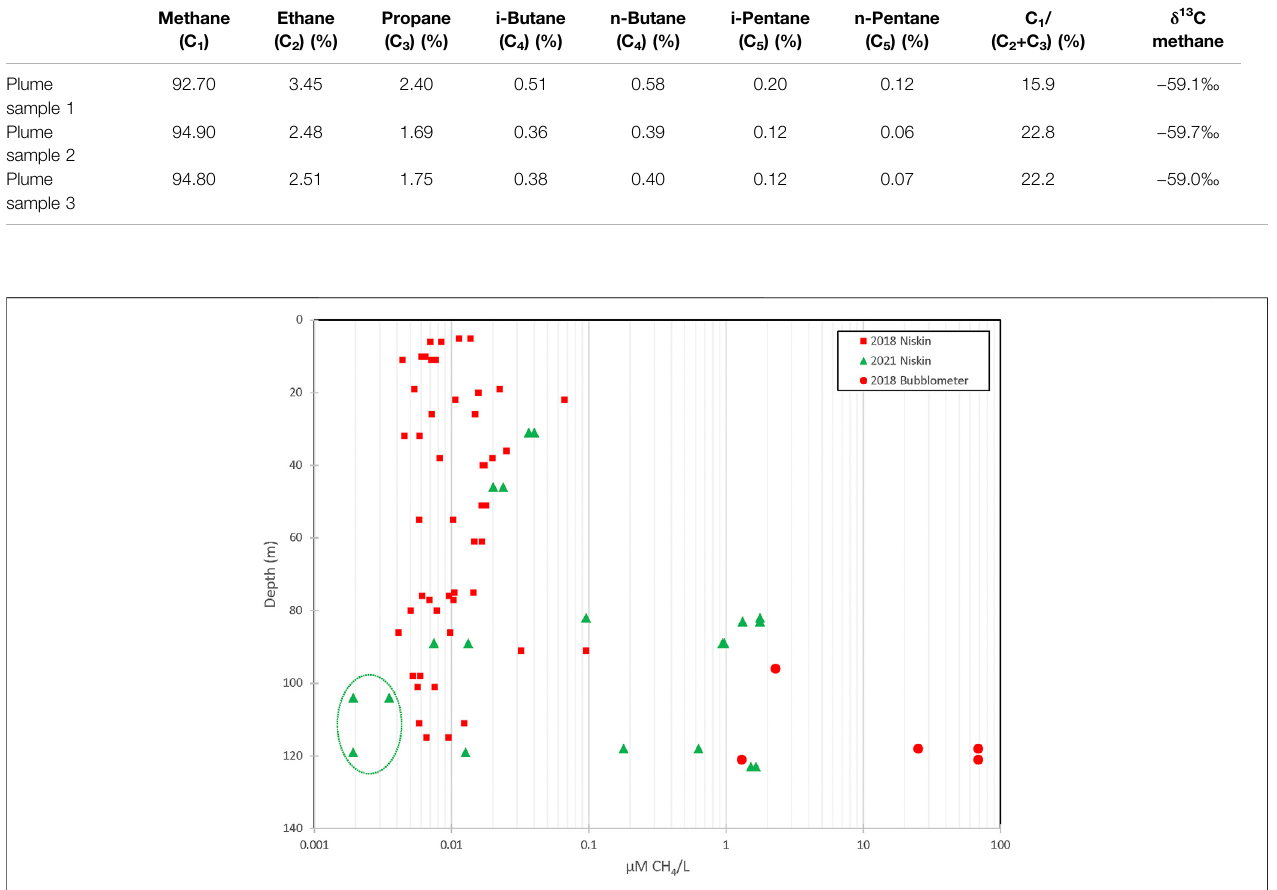
FIGURE9| Methaneconcentrationsinthewatercolumn:samplesfrom2018(redsquares)werecollectedwithNiskinbottlesdeployedwithintheoilandgasplume pro fi le and with the pressurized cylinders sealed at depth by using the bubblometer (red circles). Samples from 2021 (green triangles) were collected by Niskin bottles deployed from an ROV in the oil-free gas plume with bubble presence veri fi ed by a real-time video; background reference samples were collected at a location ~35 m from the bubbles source (dashed circle).